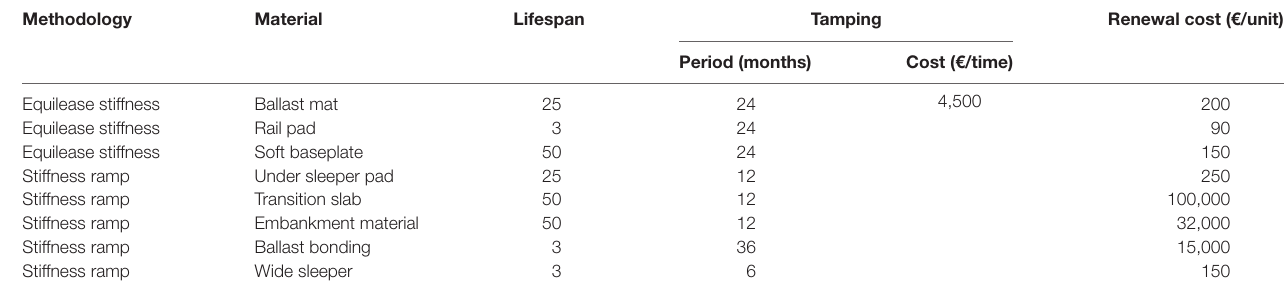
TaBle 3 | Assumptions table for lifespan and maintenance in control